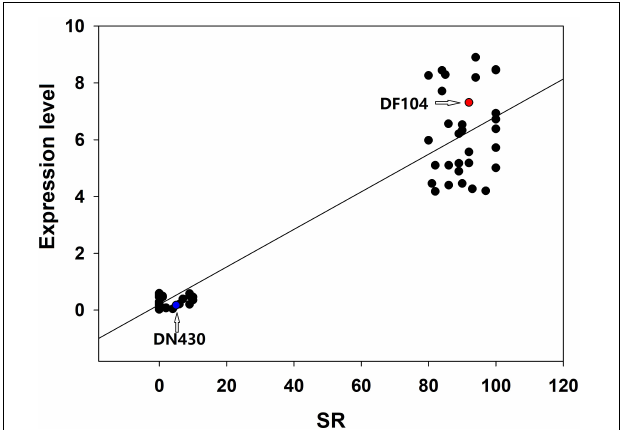
FIGURE 5 | Correlation between the expression level of Os09g0444200 and seed survival rate in 30 cold-tolerant lines and 30 cold-sensitive lines after cold